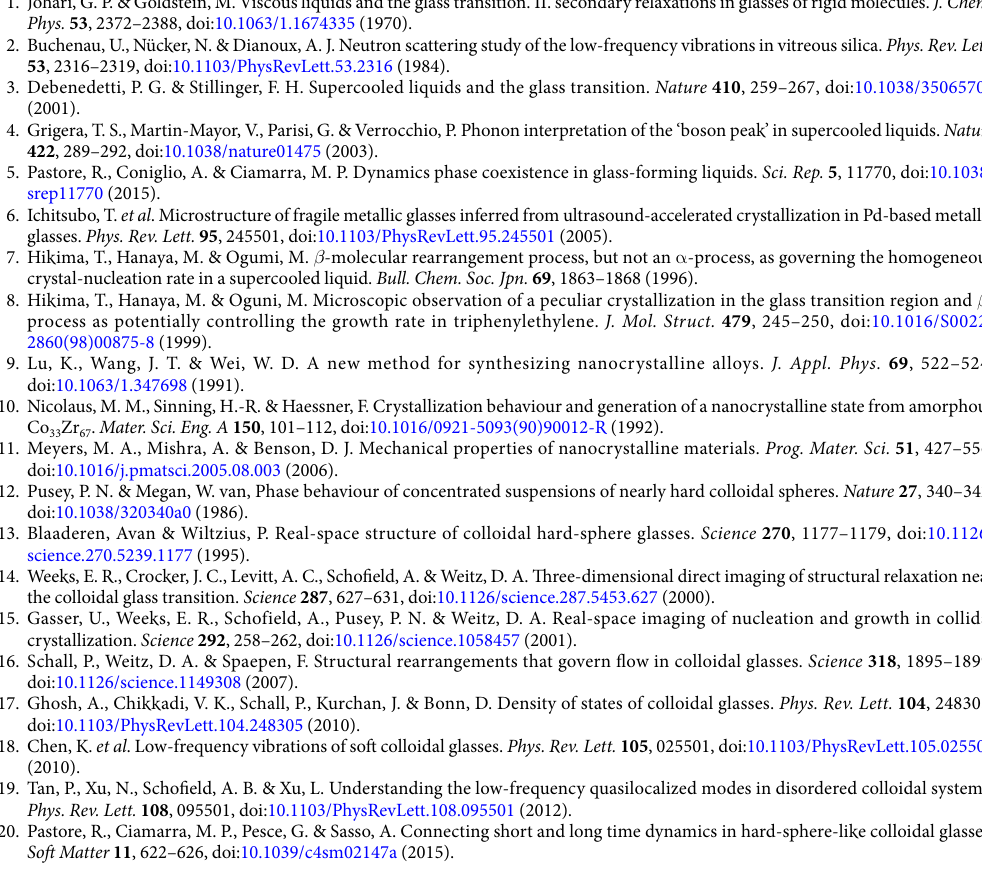
6 Scientific RepoRts | 7: 1369 | DOI:10.1038/s41598-017-01484-y